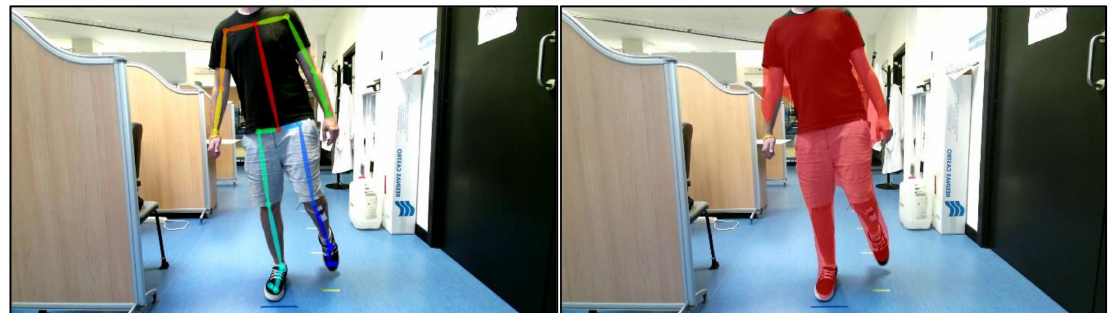
Figure 8. Frame of a recording to appreciate the correspondence between the human skeleton display by OpenPose ( left ) and the mask calculated by the Mask RCNN network ( right